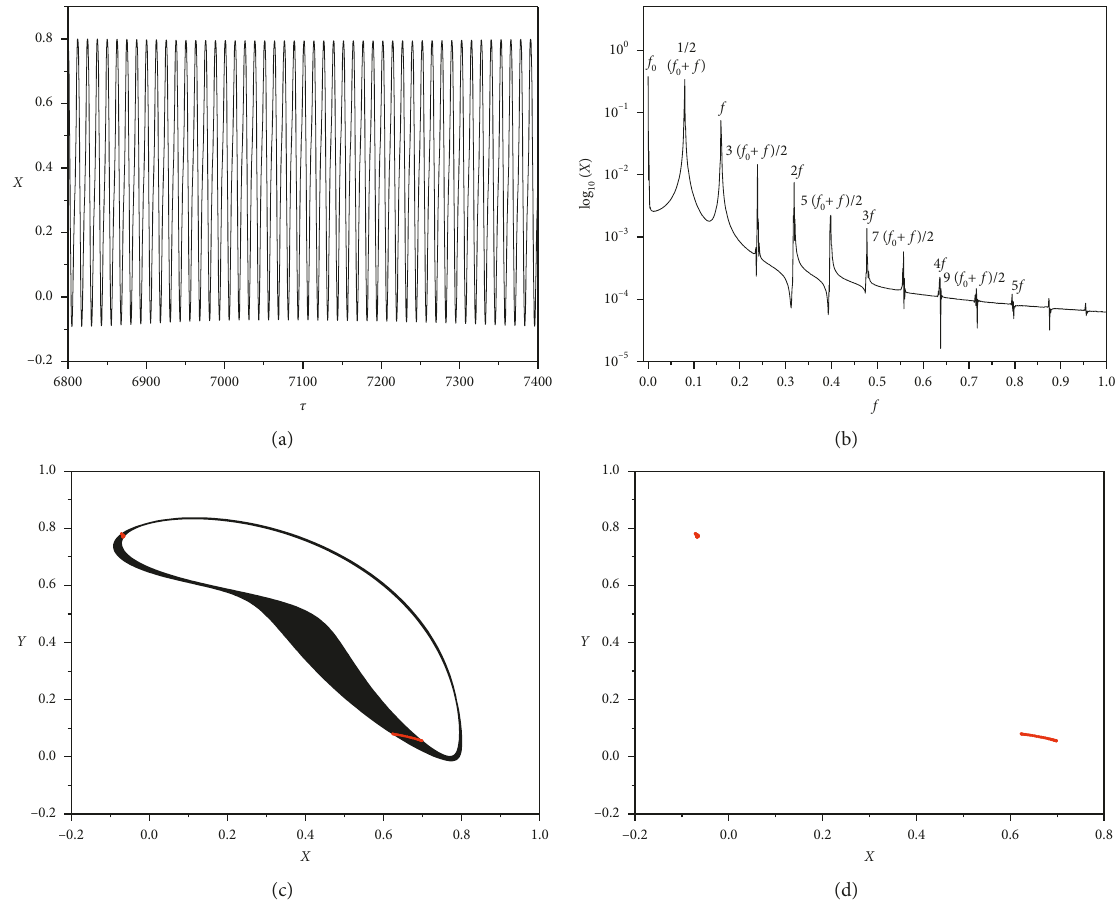
Figure 7: (a) Displacement. (b) Frequency response. (c) Rotor orbit. (d) Poincar´e map where